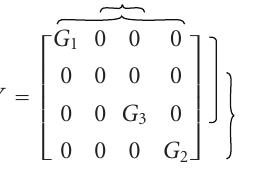
Figure 3: The generalized two conveyor two integrator loop